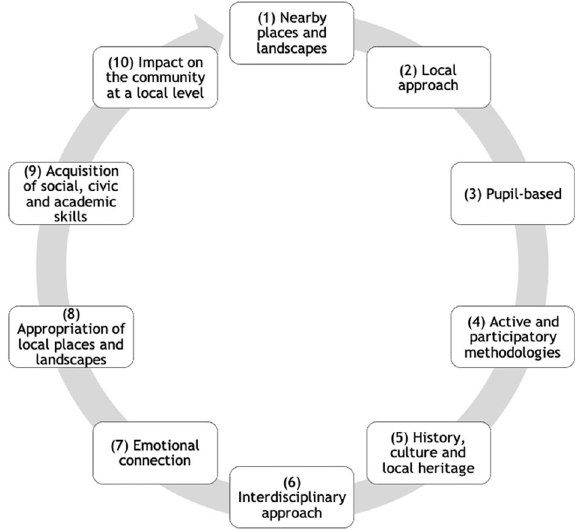
Fig. 1 Teaching proposal for Landscape and Sustainability. Ten dimensions of the proposal, based on Place-Based Education and Heritage